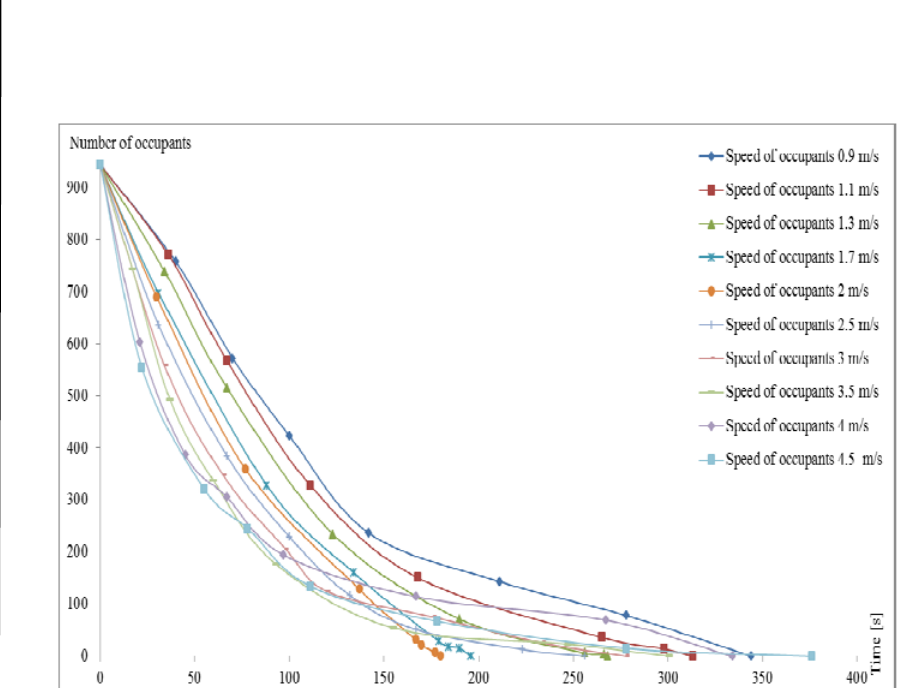
Figure 10 – Complete simulation results for the second scenario Рис . 10 – Результаты моделирования по второму сценарию Слика 10 – Комплетни резултати симулације за други